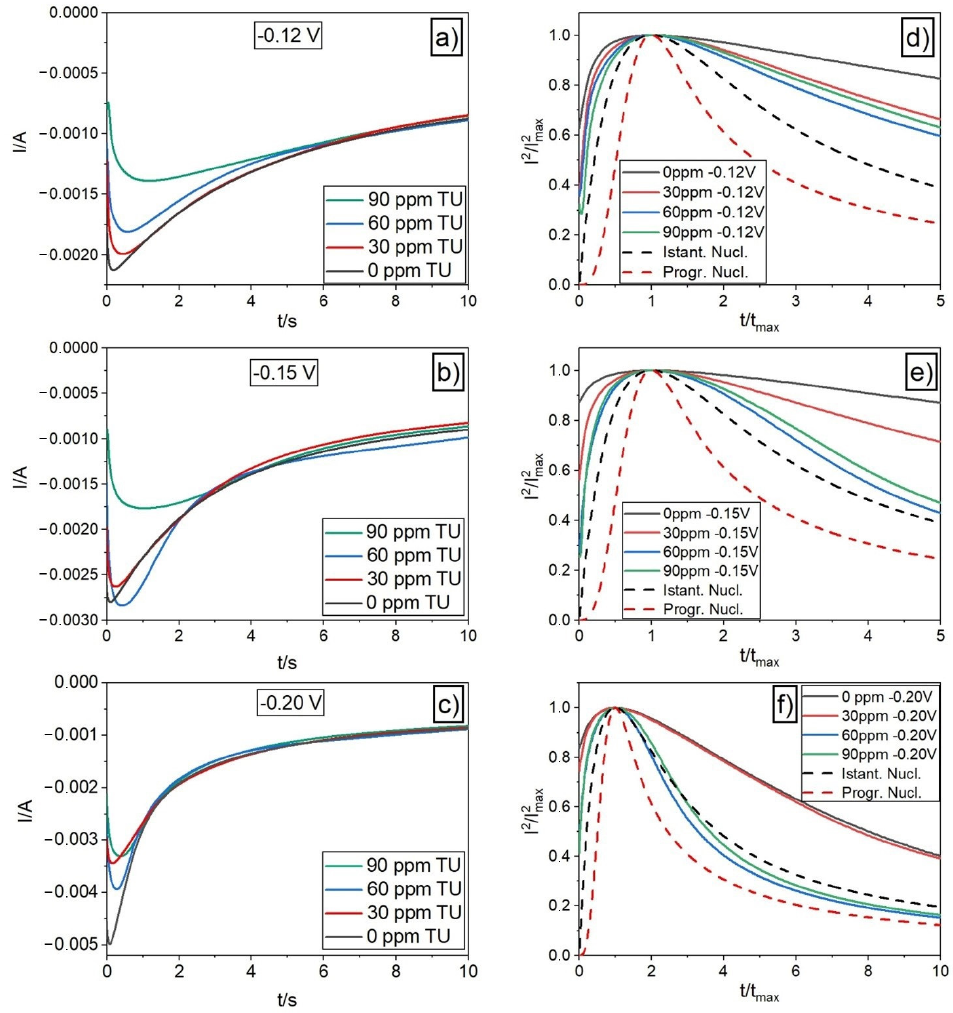
Figure 2. Current transients recorded at various TU concentrations at potentials: ( a ) − 0.12; ( b ) − 0.15; ( c ) − 0.20 V. ( d – f ) are the same current transients but normalized with respect to J 2 /J m2 vs. t/t m to be able to compare them with the theoretical instantaneous and progressive curves (dashed lines) of the Scharifker-Hills